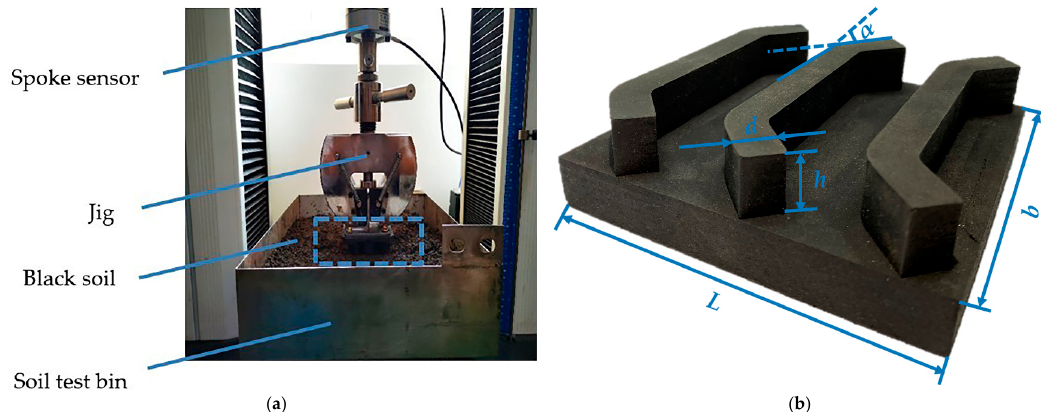
Figure 2. Overall structure of the test platform. ( a ) A soil bin test; ( b ) structure of the grouser shoes. L is the length of grouser shoe, b is the width of grouser shoe, h is the grouser height, d is the grouser thickness, and α is the grouser splayed angle.